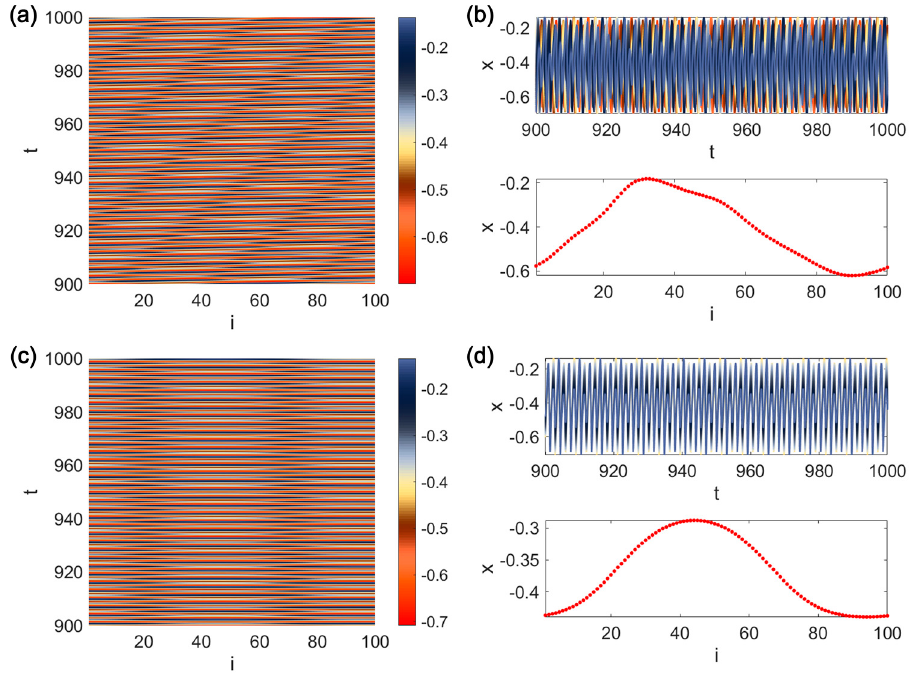
Figure 7. ( a ) The spatio-temporal patterns of locally coupled FMW neurons, as well as ( b ) the neurons’ time series and the snapshot of the last samples for 𝐷 = 20 . ( c ) The spatio-temporal patterns of locally coupled FMW neurons, as well as ( d ) the neurons’ time series and the snapshot of the last samples for 𝐷 = 70 . 𝛼 = 0.95 is considered.